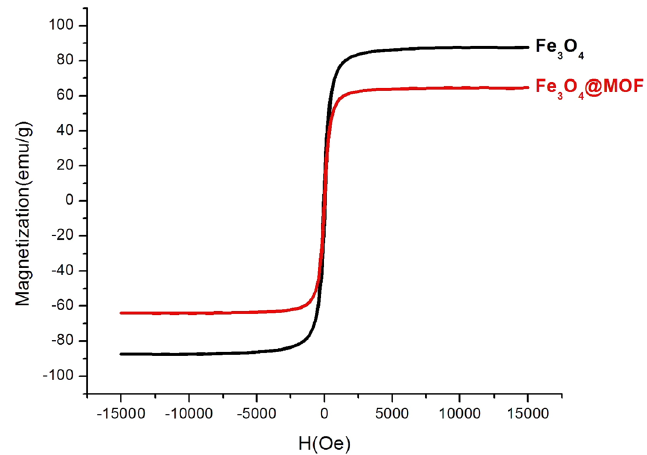
Figure 10. VSM graphs of ( a ) Fe 3 O 4 and ( b ) Fe 3 O 4 @HKUST-1.